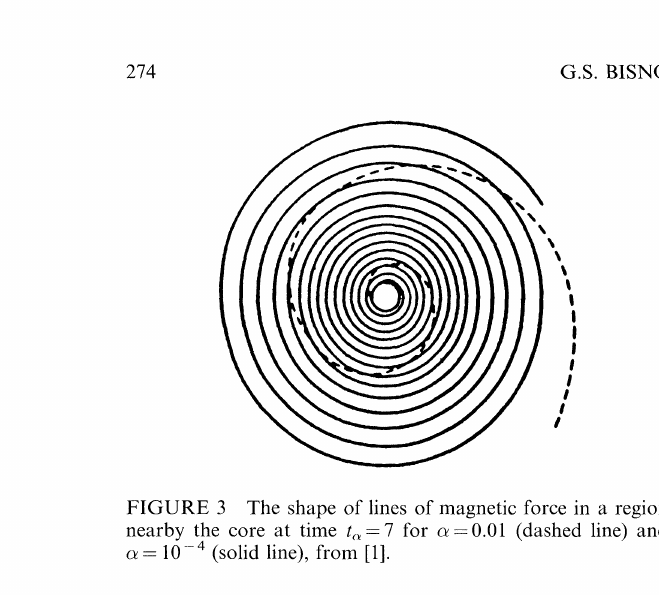
FIGURE 3 The shape of lines of magnetic force in a region nearby the core at time t(= 7 for c =0.01 (dashed line) and oz 10 -4 (solid line), from [1].